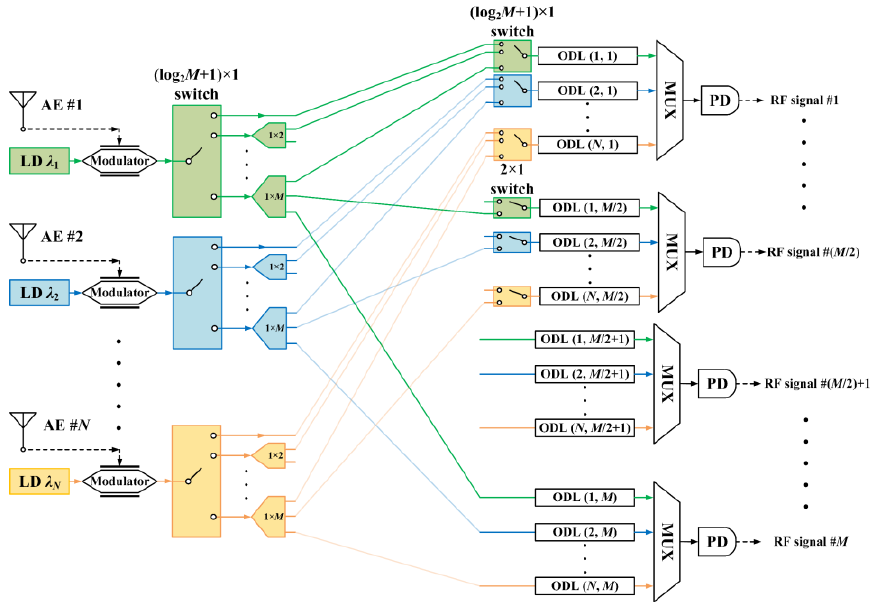
Figure 2. Illustration of structure DP(descending-precedence).